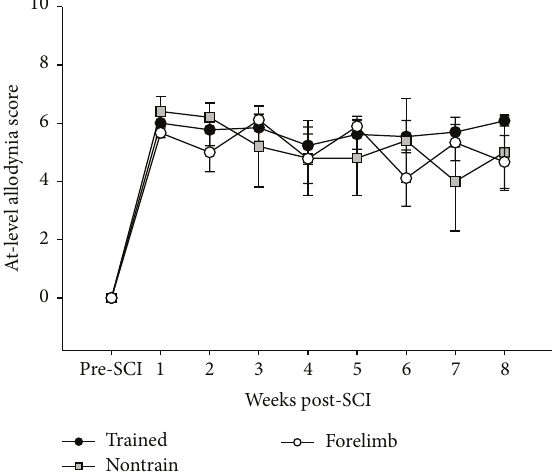
Figure 5: No animals were sensitive to touch or gentle squeeze prior to injury. Immediately after SCI, all rats exhibited a moderate degree of evoked at-level allodynia. There were no differences between groups regarding the course of at-level allodynia.